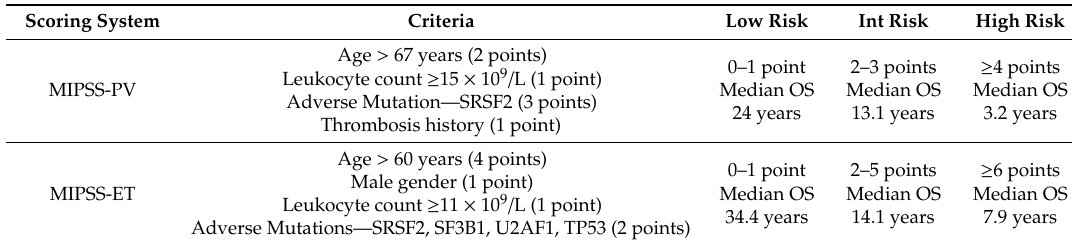
Table 1. Adapted from [9] showing incorporation of molecular risk factors and median overall survival (OS) for respective risk groups; Int,